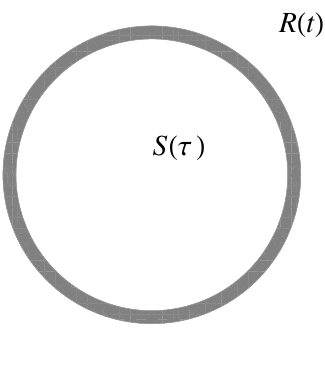
Figure 1. The collapsing region is modelled by a part of a closed universe with the scale-factor S ( τ ) . Outside the perturbed region the flat universe is assumed with the scale-factor R ( t ) . Additionally, some transition layers are